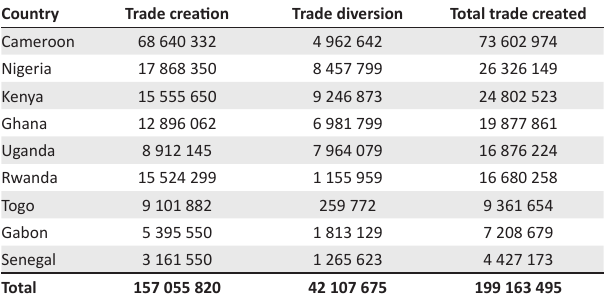
TABLE 3: Total trade creation for South Africa on the African Union market (US$). Country Trade creation Trade diversion